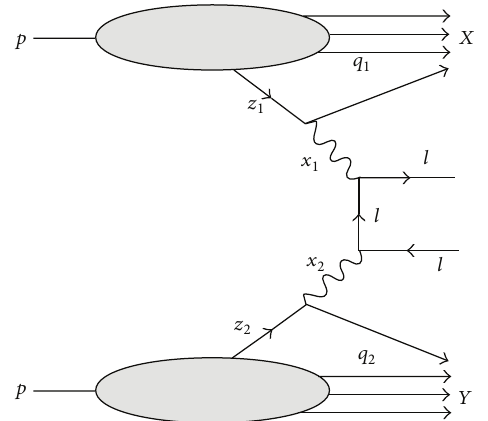
Figure 15: Inelastic photoproduction of a lepton pair at the LHC. The photons are coming from the quarks inside